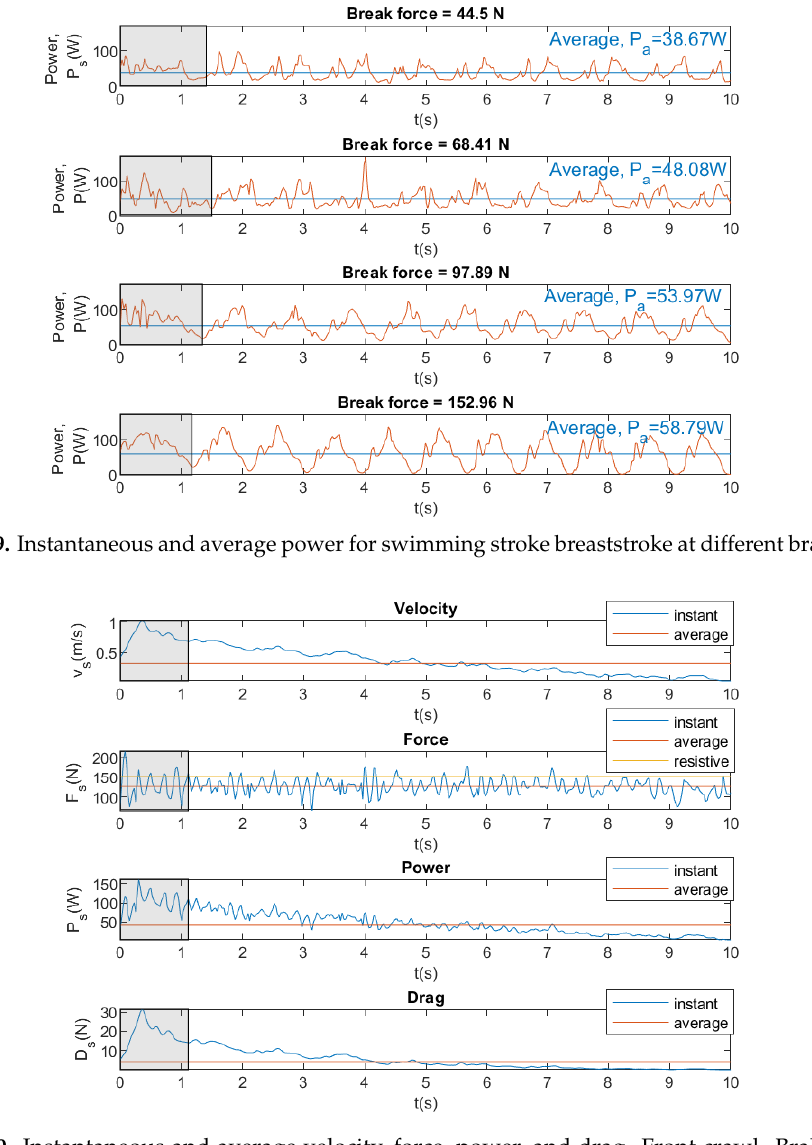
Figure 20. Instantaneous and average velocity, force, power, and drag. Front crawl. Brake force = 152.96